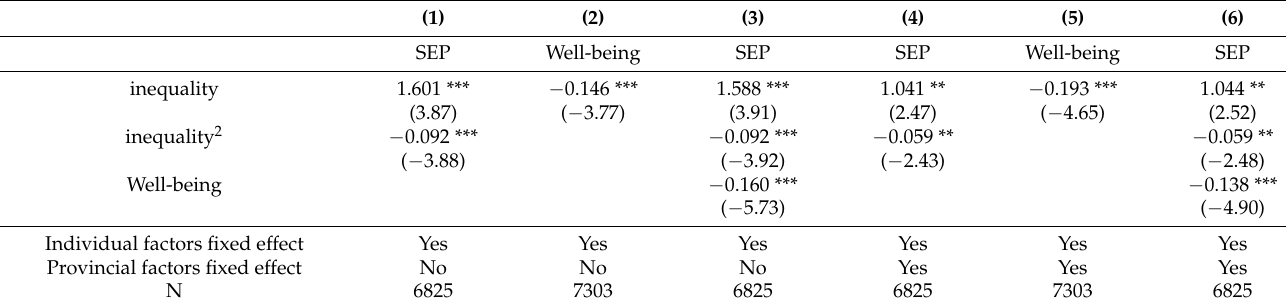
Table 14. The mechanism of the effect of individual-level income inequality on subjective environmental pollution: the effect of subjective well-being.